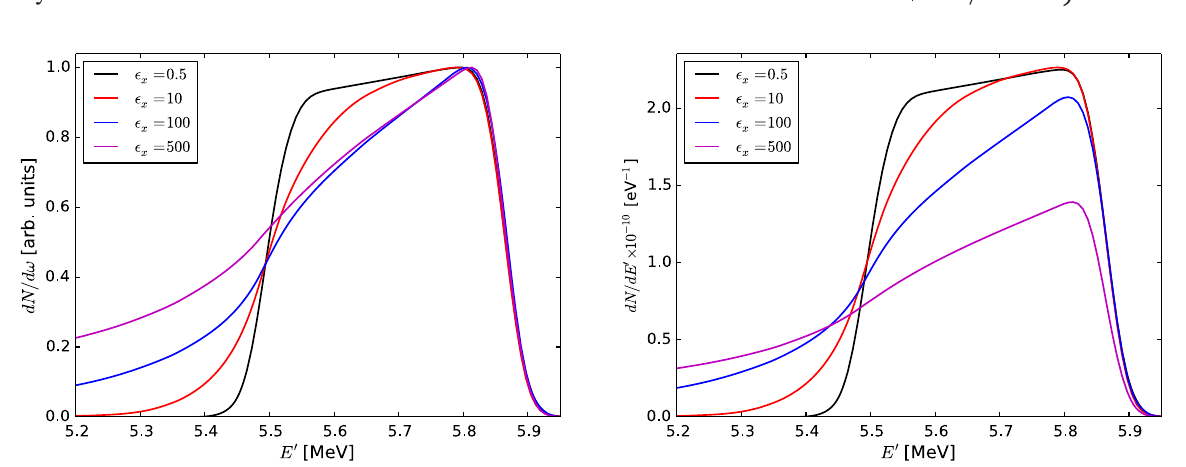
FIG. 3. The number density of the energy spectrum of a Compton gamma-ray beam produced by the head-on collision of a 500 MeV electron with a 800 nm pulsed laser beam, for different horizontal emittances ϵ x as in Fig. 4(a) in Ref. [7]. The laser is collimated by an aperture with radius of 16 mm, placed 60 m downstream from the collision point. The relative energy spread of the electron beam σ E is held constant at 2 × 10 − 3 . Here a Gaussian laser pulse with σ ¼ 50 is used, while the laser in Ref. [7] is CW. Each curve is generated by averaging 400 electrons sampling the prescribed distribution. Left panel: Spectra scaled to their respective peak values (compare with Fig. 4(a) of Ref. [7]). Right panel: Spectra in physical